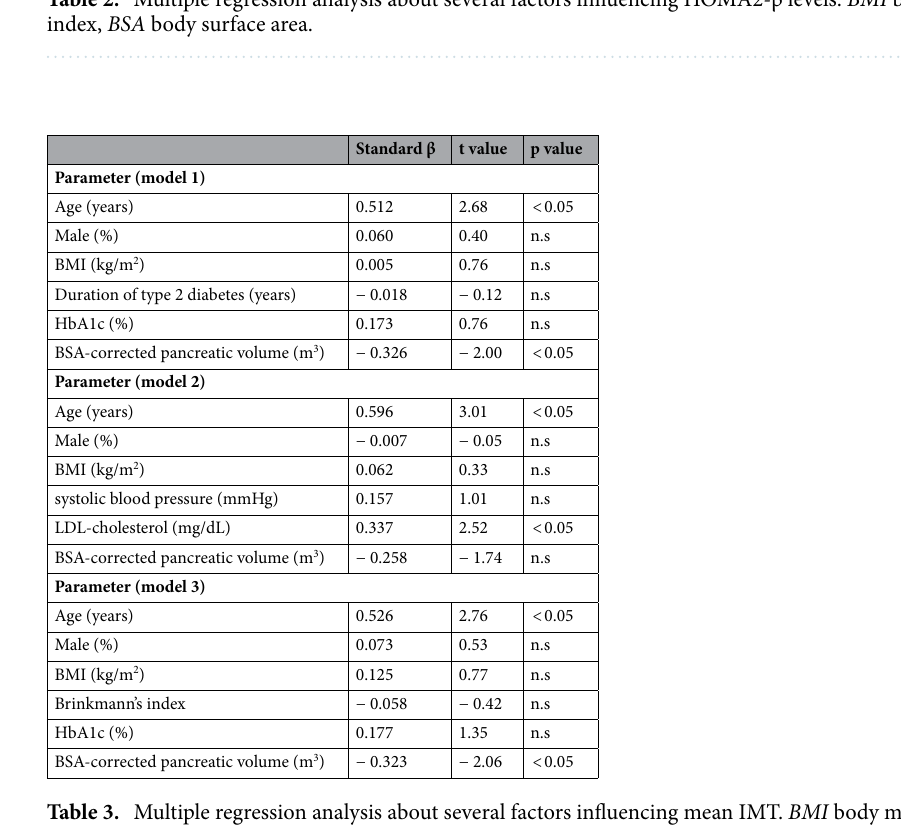
Table 3. Multiple regression analysis about several factors influencing mean IMT. BMI body mass index, BSA body surface area, LDL -cholesterol low-density lipoprotein